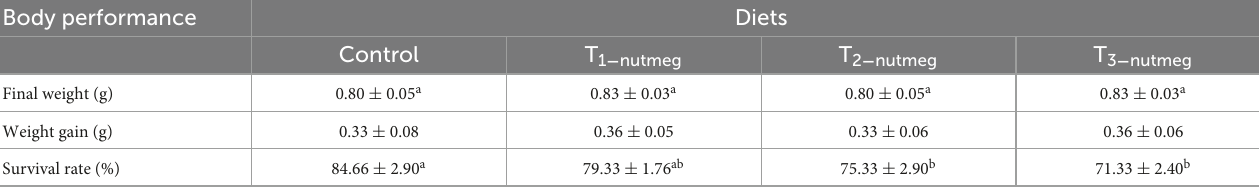
TABLE 4 Growth performance and survival rate of zebrafish fed the experimental diets. Body performance